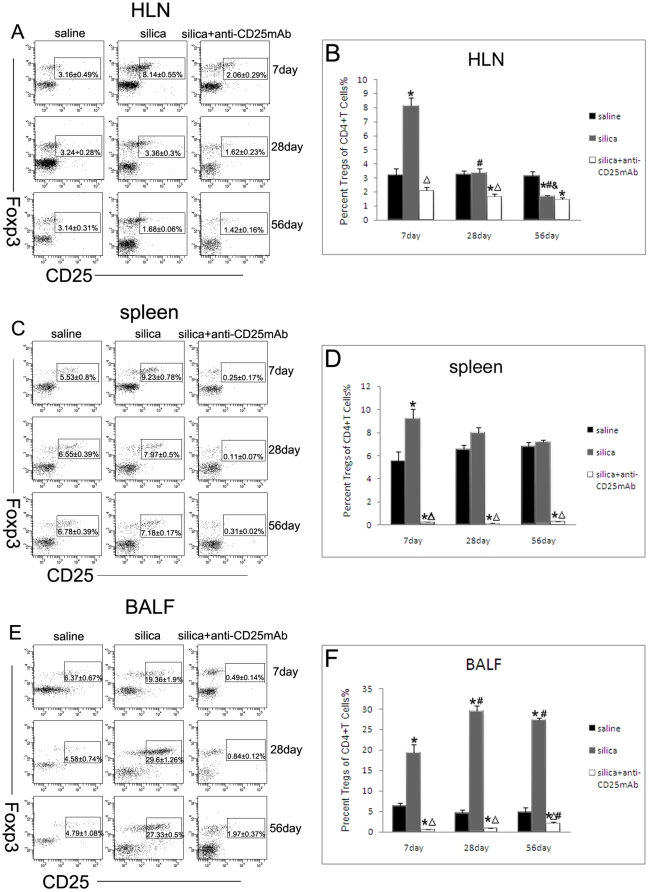
CD4+CD25+FOXP3+ T cells were the functional fraction of Treg cells in the silica-induced lung fibrosis.Treg cells in HLN (A), spleen (C) and BALF (E) were calculated by flow cytometry. (n = 5) The percentage of CD4+ T cells expressing CD25 and FOXP3 was shown in the graph (B, HLN; D, spleen; F, BALF) (n = 5) (*, as compare with the saline control group, P<0.05; △, as compare with the silica group, P<0.05; #, as compare with 7day of the same group, P<0.05; &, as compare with 28day of the same group, P<0.05).